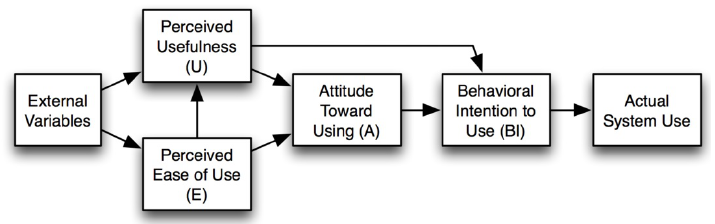
Figure 6. Technology Acceptance Model